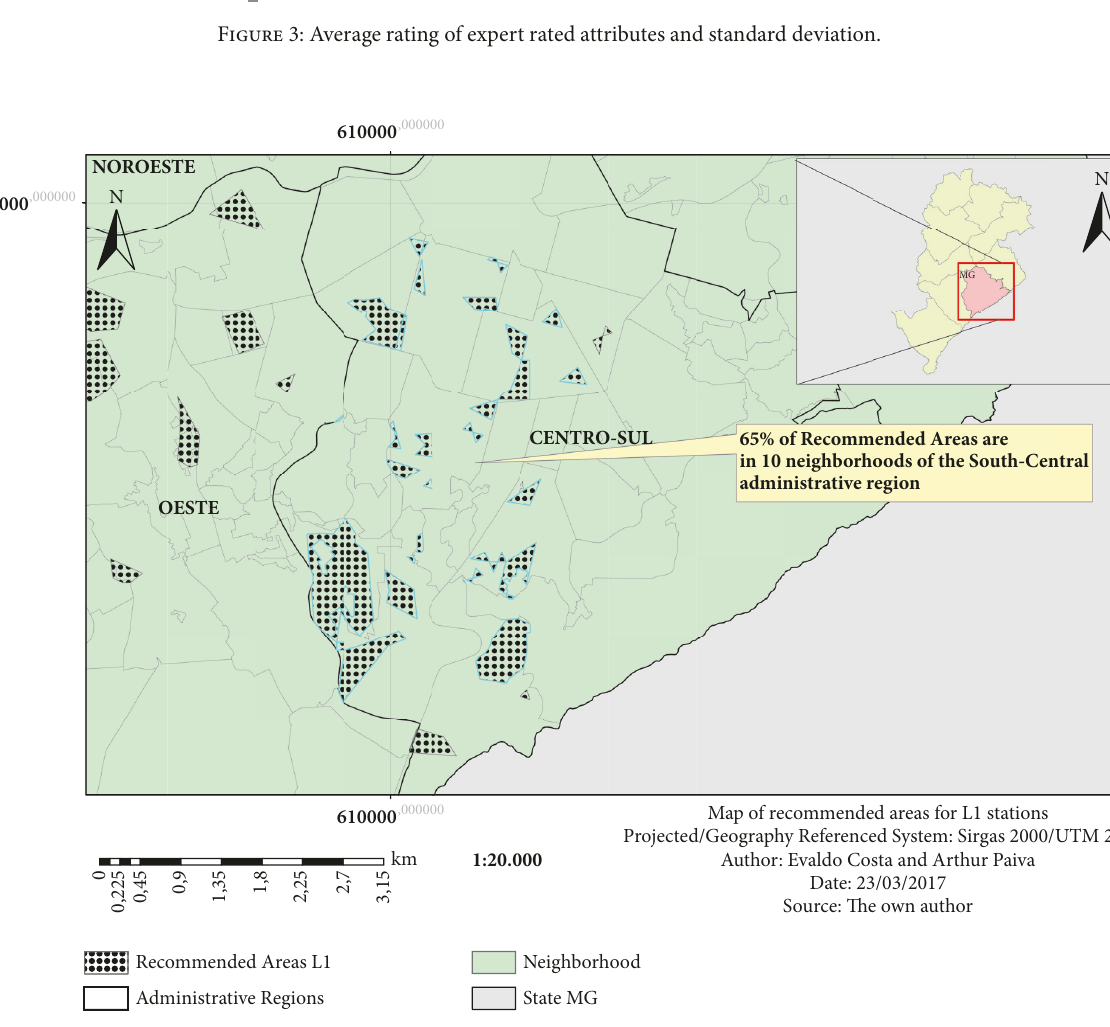
Figure 4: Optimal locations for EVSE